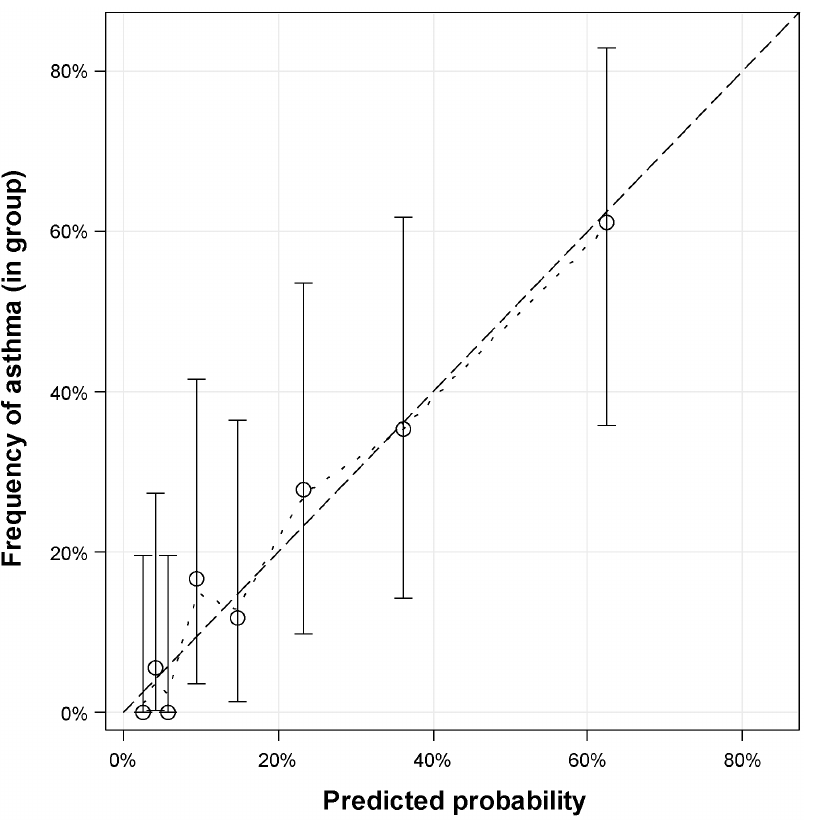
Fig. 4. Calibration assessment, predicted probabilities vs. real asthma frequencies in eight equally assigned groups. Exact 95%-confidence intervals for actual asthma frequency based on beta/binominal distribution. Penalized B-Spline (2 nd degree) aiding graphical interpolation (dotted line). Perfect calibration at diagonal (dashed line). Primary inclusion, scoring, and outcome definitions.